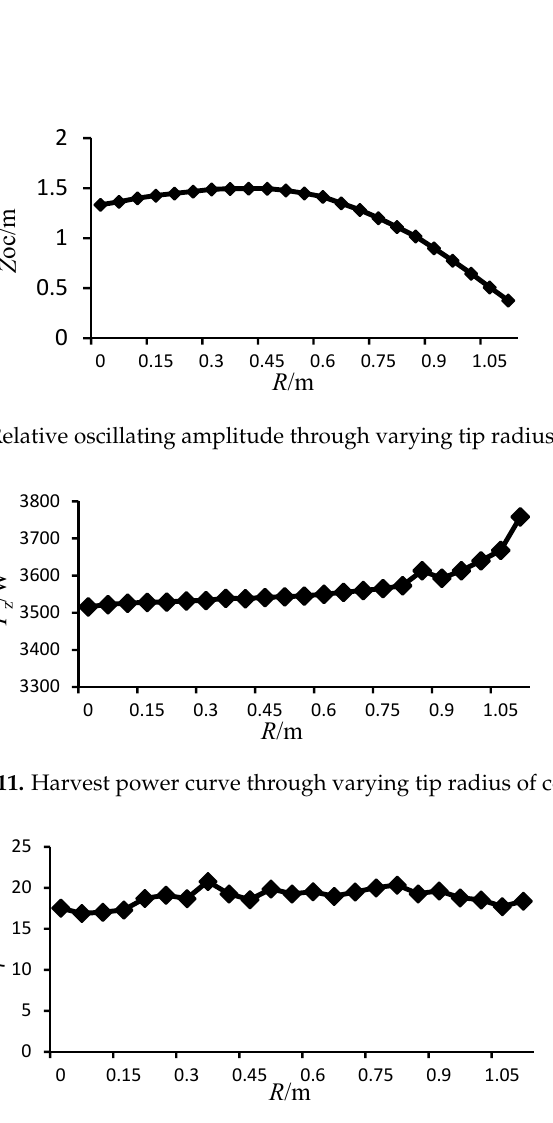
Figure 12. Power harvest efficiency through varying tip radius of cone.